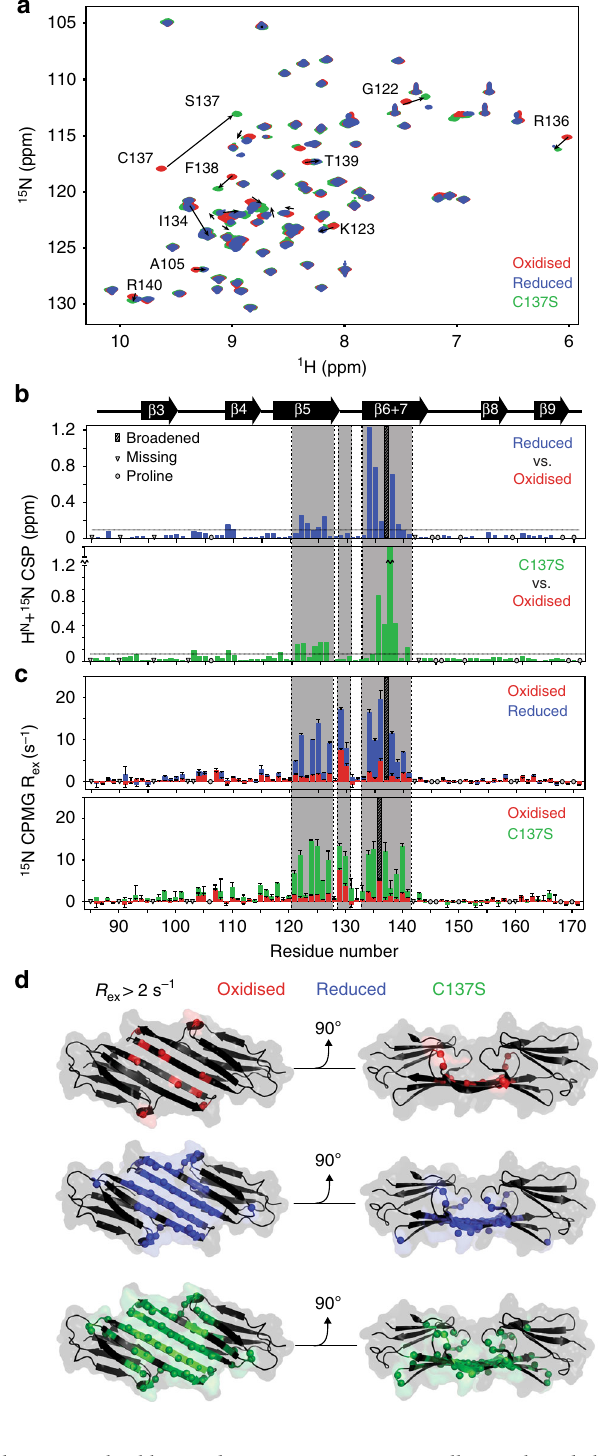
Fig. 4 Redox-induced perturbations to the structure and dynamics of cHSP27. a Overlaid 2D 1 H- 15 N HSQC spectra of oxidised (red), reduced (blue, + 5 mM BME), and C137S (green) cHSP27 reveal their structural similarities. Signi fi cant CSPs are indicated with arrows. b CSPs for individual residues between reduced (top) or C137S (bottom) and the oxidised state reveal differences that localise to the β 5 and β 6 + 7 strands. The resonance from C137 was broadened beyond detection in reduced cHSP27 (cyan). Proline residues that do not contribute to this spectrum and unassigned residues are indicated. CSPs were calculated as √ ( Δ H² + (0.2 Δ N²)). c R ex versus residue number, which qualitatively probes μ s – ms motions. Errors bars are 1 SD, as derived from propagation of the fi tted errors in measured R 2,eff values. Residues near L 5,6 + 7 show large R ex values in oxidised, reduced, and C137S cHSP27. The motion extends into the β 5 and β 6 + 7 strands for reduced cHSP27 and C137S. d R ex values > 2 s − 6 1 H